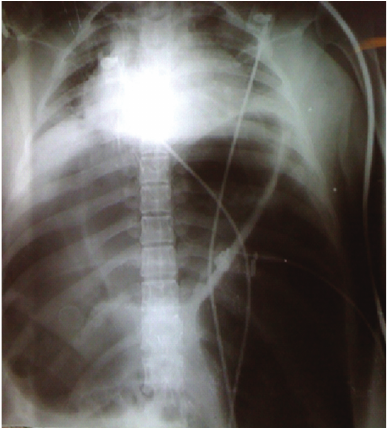
Figure 1: Plain radiography of the chest and abdomen showing severe distension of the transverse and sigmoid colon leading to a lung